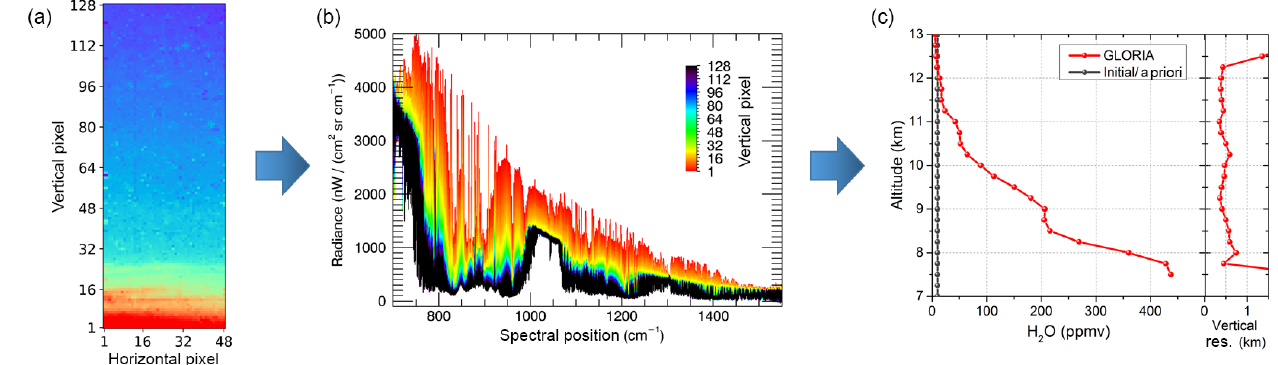
Figure 2. Brief illustration of the GLORIA data processing. (a) Raw single image of the detector array. (b) Set of 128 radiometrically and spectrally calibrated spectra representing one measurement. (c) Vertical profile of H 2 O (courtesy: Wolfgang Woiwode, KIT).